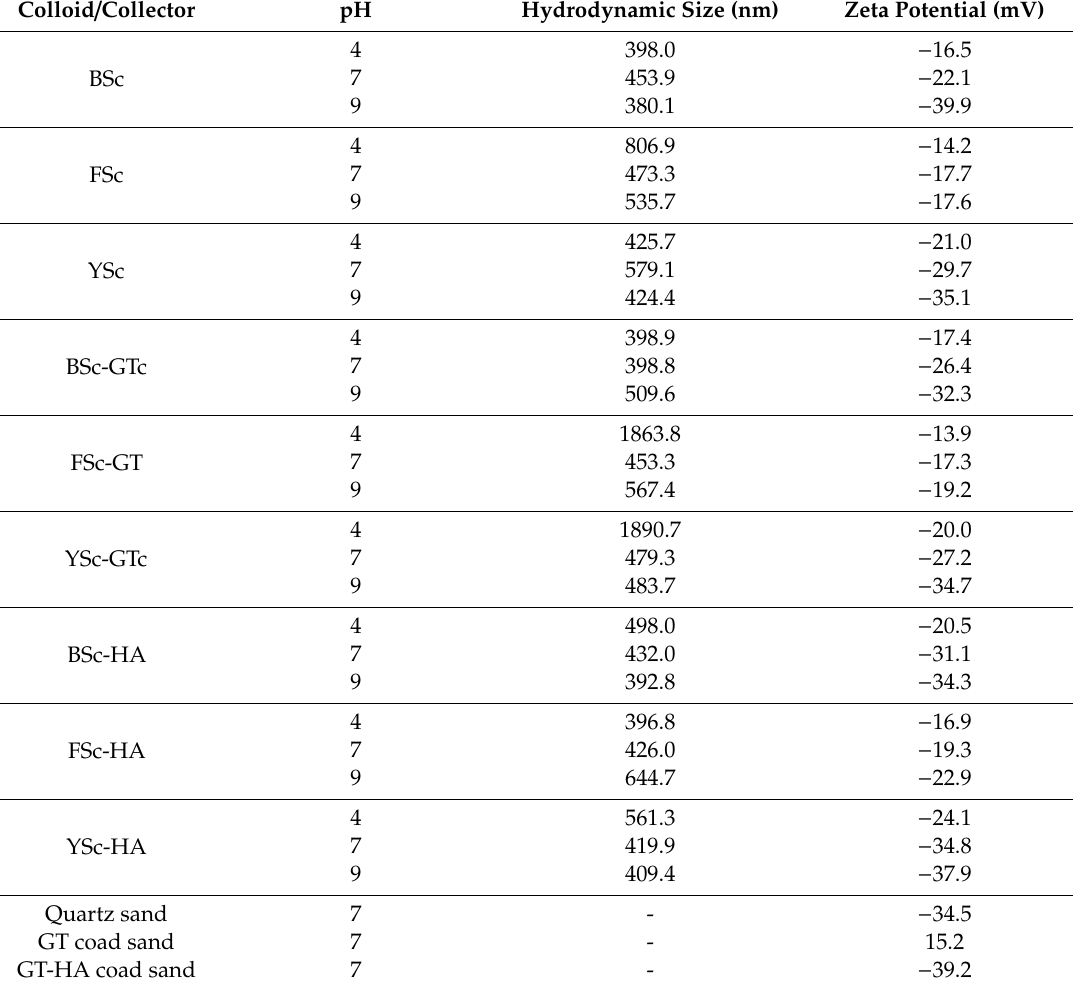
Table 1. Hydrodynamic sizes and zeta potential of the soil colloids, mixed colloids, and collector. Colloid /